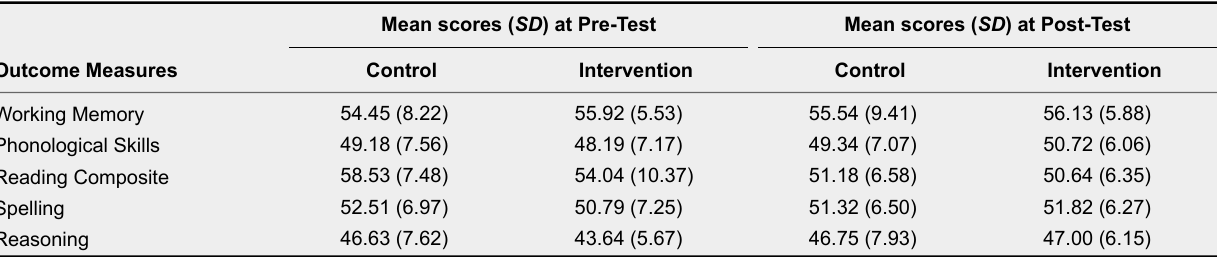
Means and Standard Deviation (SDs) for Working Memory Composite, Phonological Skills, Reading Composite, Spelling and Reasoning for Intervention and Control Conditions Pre- and